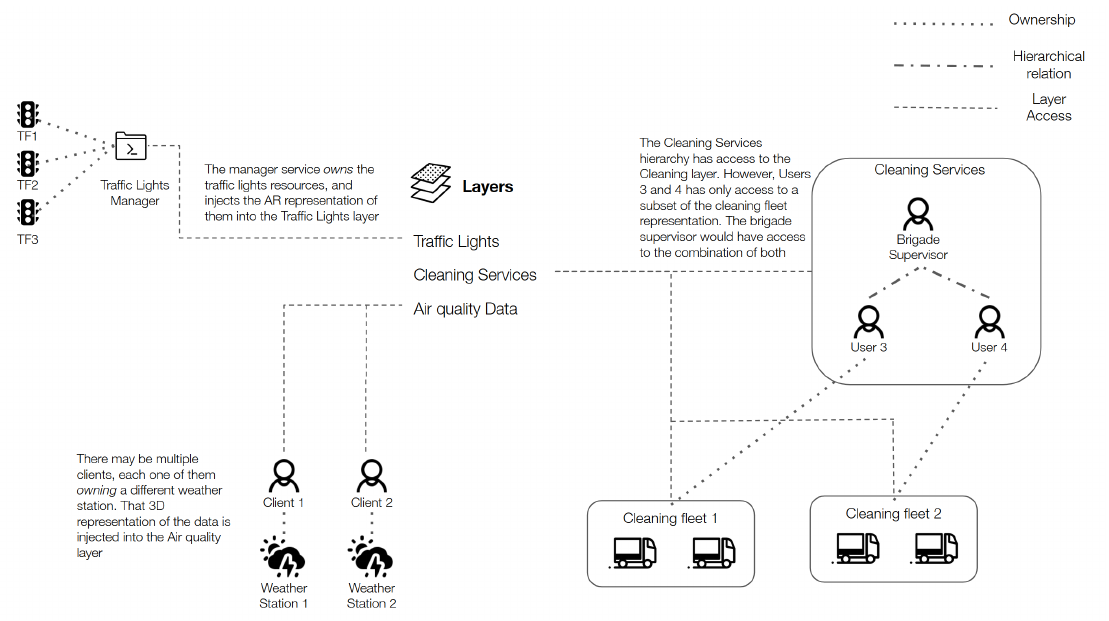
Figure 2. Collaboration